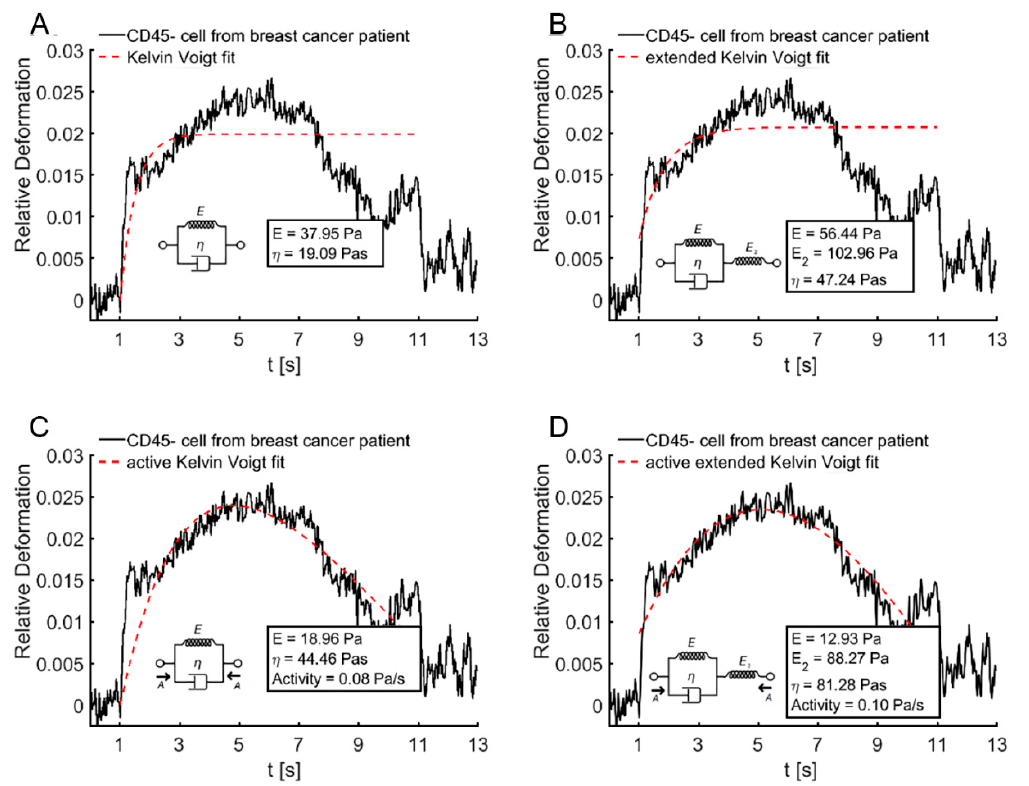
Figure A2. The four different Kelvin–Voigt based models on the example of a highly active cell. ( A ) shows the basic Kelvin–Voigt model. It is well visible that the model fails to adapt both to the sudden elongation at the beginning of the stretching phase at 1 s and the contractile behavior starting at 5 s. ( B ) The extended Kelvin–Voigt model has an additional spring to adjust for the steep jump at the beginning of the stretching phase. E 2 has to be considerably high to adjust for the elastic cutoff soon after. ( C ) Introducing activity as a measure of active cell contraction allows the model to fit the contraction of the cell. ( D ) Adding the extended spring E 2 to the active model improves capture of the initial jump, but the high elasticity needs to be countered by a slightly increased activity value. For the evaluation of activity throughout the paper, only the activity data of the active ( C ) and not the active extended ( D ) model were taken into account.